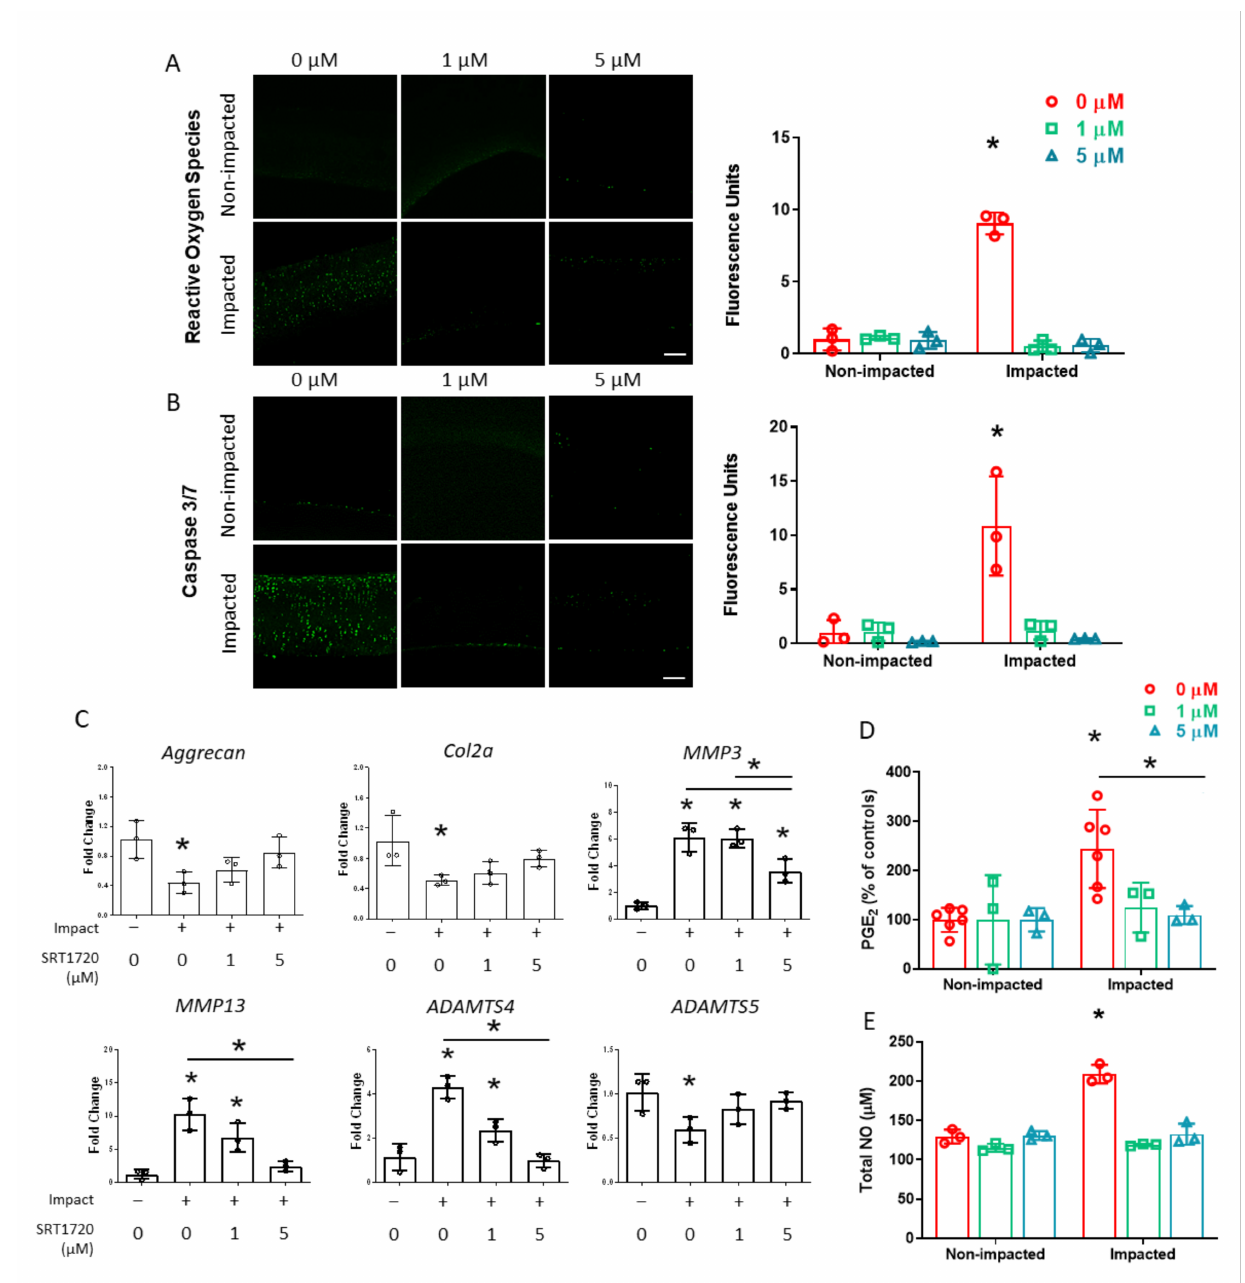
Figure 3. Impact-induced injury response is prevented with pharmacological SIRT1 activation. ( A ) Staining for reactive oxygen species and quantification of mean intensity ( n = 3). Scale bar = 200 µ m. * indicates significant difference from all other groups, p < 0.05 ( n = 3). ( B ) Staining for activated caspase 3/7 and quantification of mean intensity. Scale bar = 200 µ m. * indicates significant difference from all other groups, p < 0.05 ( n = 3). ( C ) Anabolic and catabolic mRNA expression 24 h post impact relative to 18s expression. * over bar indicates significant difference from non-impacted, untreated control group, p < 0.05. * over line indicates significant difference between treatment groups in impacted specimens, p < 0.05 ( n = 3). ( D ) PGE 2 secretion to media 24 h following impact injury. * over bar indicates significant difference from non-impacted, untreated control group, p < 0.05. * over line indicates significant difference between treatment groups in impacted specimens, p < 0.05 ( n = 3 or 5). ( E ) NO secretion to media 24 h following impact injury. * indicates statistically significant difference from all other groups, p < 0.05 (n =